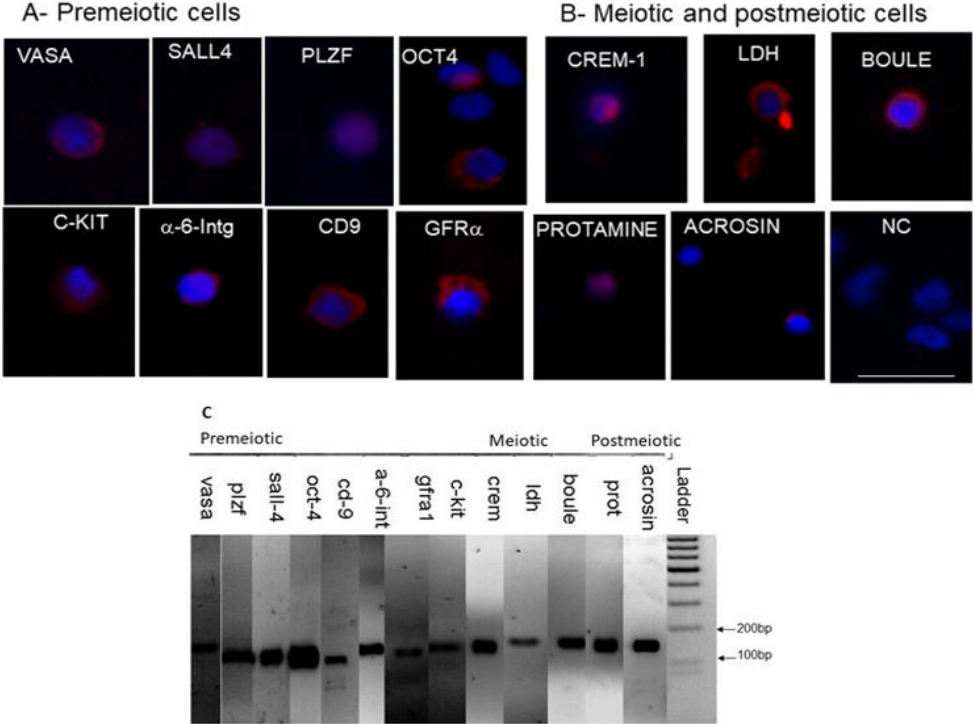
Figure 2. Immunofluorescence staining and RNA expression of spermatogenesis markers in cells isolated from biopsies of SCOS patients before and/or after culture. Enzymatically isolated cells from testicular biopsies of SCOS patients were examined by immunofluorescence (IF) staining for different markers of: ( A ) premeiotic stage (VASA, SALL4, PLZF, OCT4, c-KIT, α -6-Integrin, CD-9, and GFRa1); ( B ) meiotic stage (CREM-1, LDH, and BOULE) and postmeiotic stage (protamine and acrosin) using specific primary antibodies for each examined marker. Negative control (NC)—IF staining was performed without primary antibodies. Blue—cell nuclei stained with DAPI; red—specific marker staining. RT-PCR analysis was used to examine RNA expression of the spermatogenesis markers using specific primers for each marker ( C ). Negative control for PCR analyses was ultra-pure water instead of the cDNA. The sizes of the PCR products were 100bp–200bp. Scale bar: 100 µ